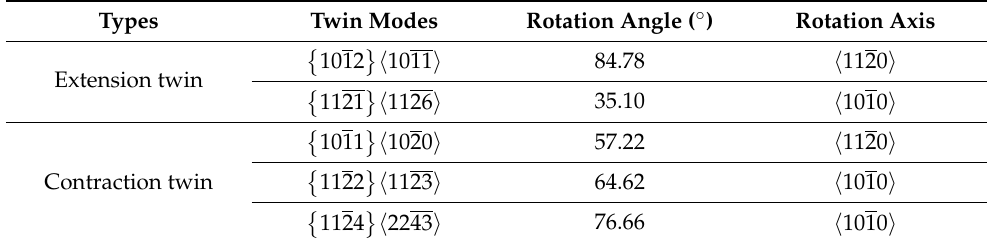
Table 4. Main twinning systems and corresponding parameters of α -Ti [28].